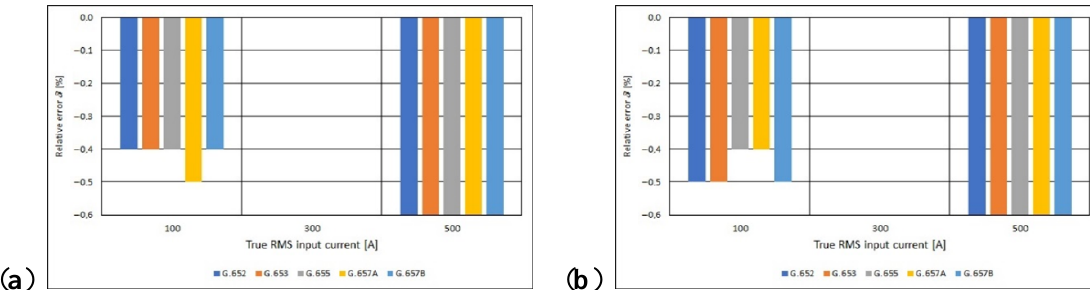
Figure 13. Values of relative error for polarimetric current sensor with measuring coil made of the different standards of single mode telecommunications fibers [own results]: ( a ) for 40-turns measuring coil and ( b ) for 80-turns measuring coil.